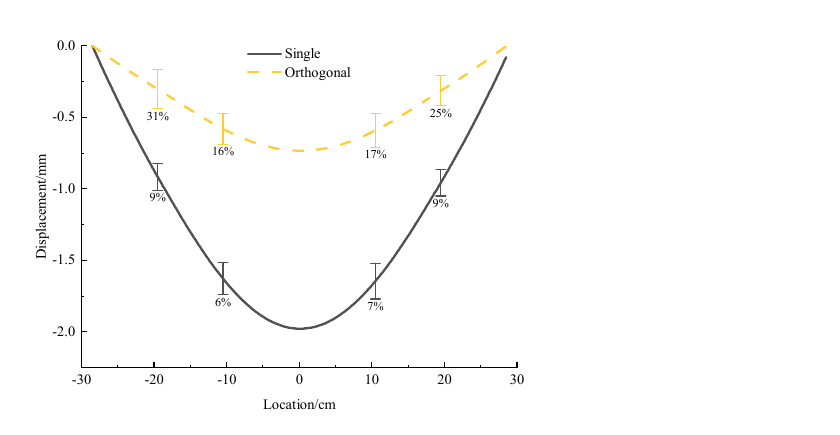
Figure 11. Comparison of deformation between 1 mm single tunnel and 1 mm+1 mm orthogonal tunnel under concentrated load.